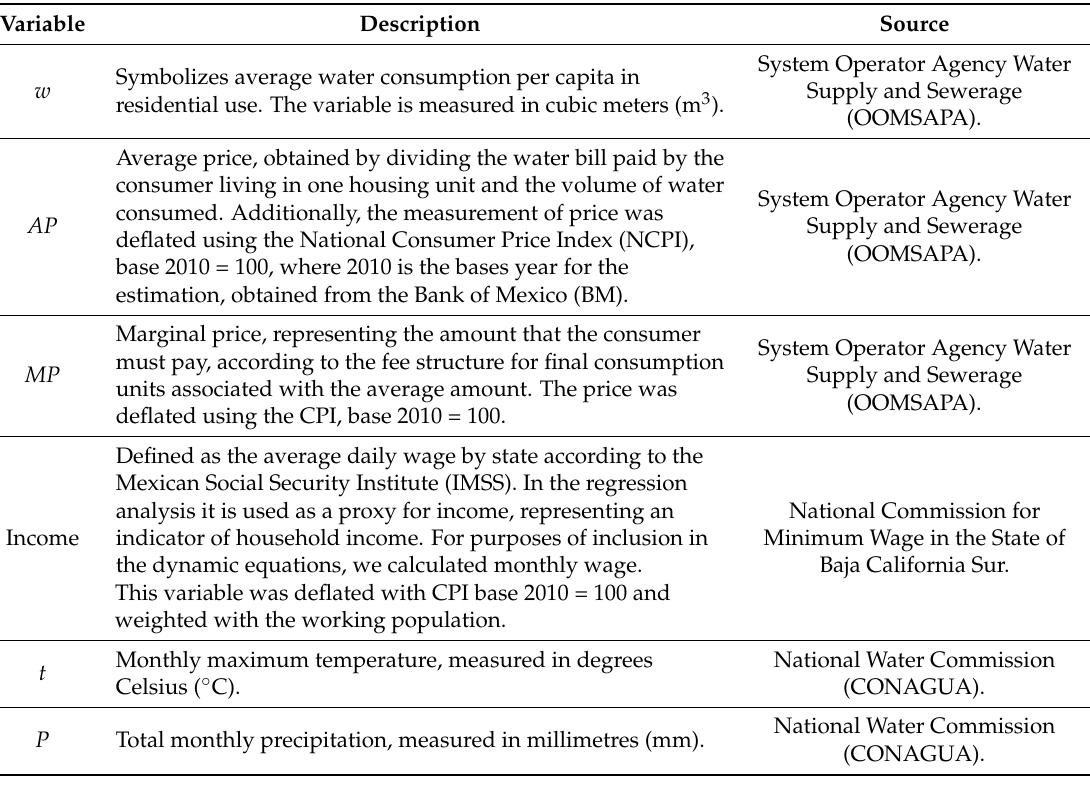
Table 1. Description of variables used in the regression analysis.